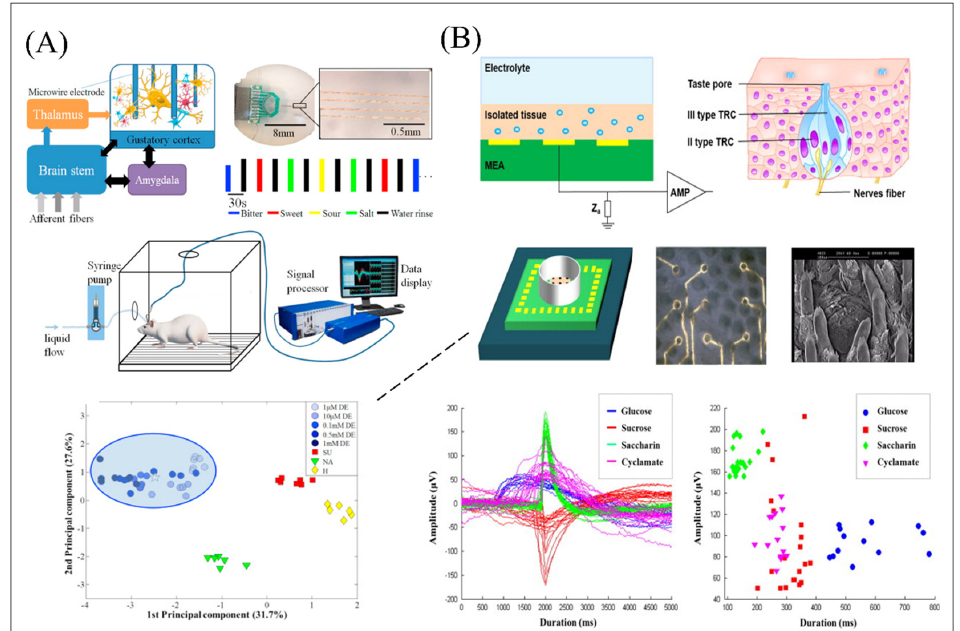
Figure 5. Schematic of biomimetic olfactory and gustatory biosensors based on electrode array functionalized with different types of sensitive materials and data analysis. ( A ) Description of gustatory signal pathway in rodents’ brain and the MEAs in vivo system coupling with specific neurons in GC for tastants detection, and the planar PCA plot with the first two principal components (PCs) accounting for 31.7% and 27.6% of the variance, respectively. Reproduced with permission from Ref. [102]. ( B ) Schematic of the microelectrode array functionalized with epithelium contained Type II taste cells for sweet detection and equipped with K-means algorithm and the signal-clustering pattern painting for data analysis. Reproduced with permission from Ref. [104].